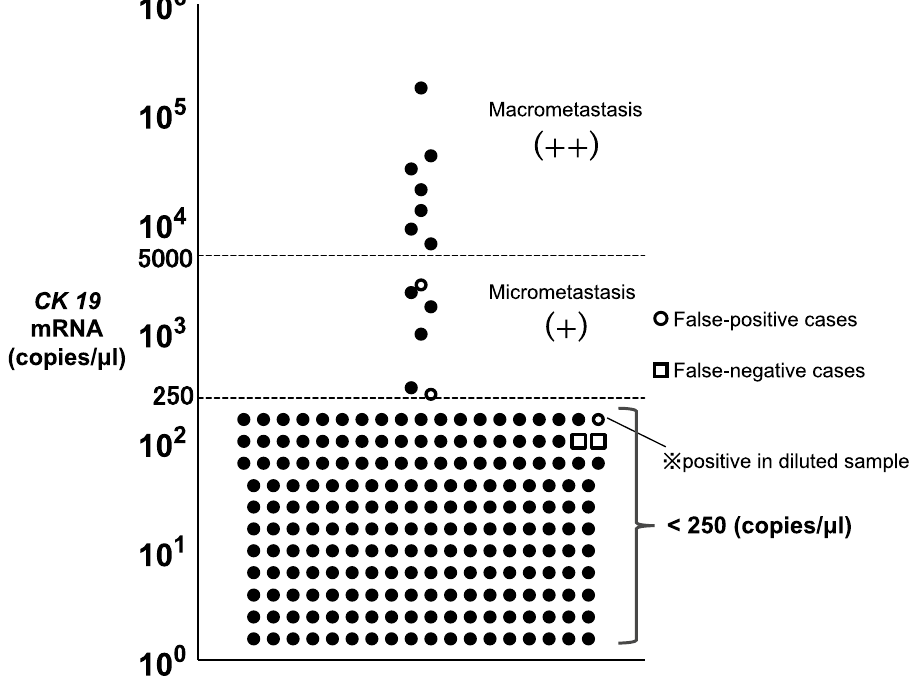
Figure 1. CK19 mRNA copy numbers by OSNA assay (n = 214). The cut-off value for micrometastasis (+) of the standard sample was set at 250–5000 copies/μl; over 5000 copies/μl was diagnosed macrometastasis (+ +) and fewer than 250 copies/μl was diagnosed as negative 31 . Three open circles show false-positive cases and two open squares show false-negative